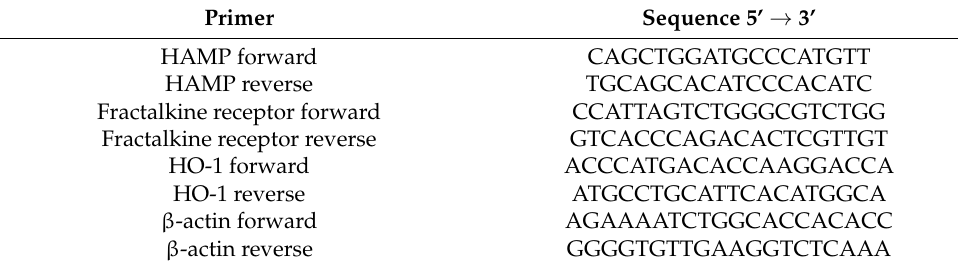
Table 1. Real-time PCR gene primer